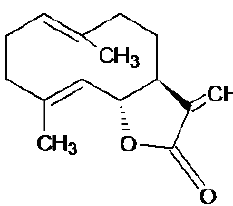
Figure 1. The chemical structure of costunolide.